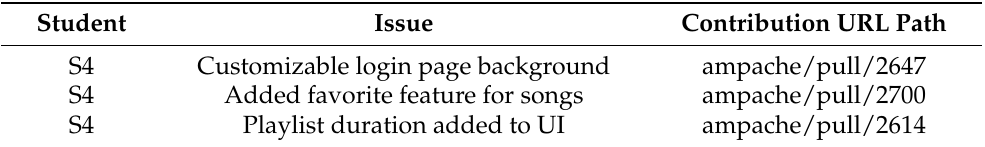
Table 2. Students’ contributions to Ampache. Base URL: https://github.com/ampache/ (accessed on 14 May